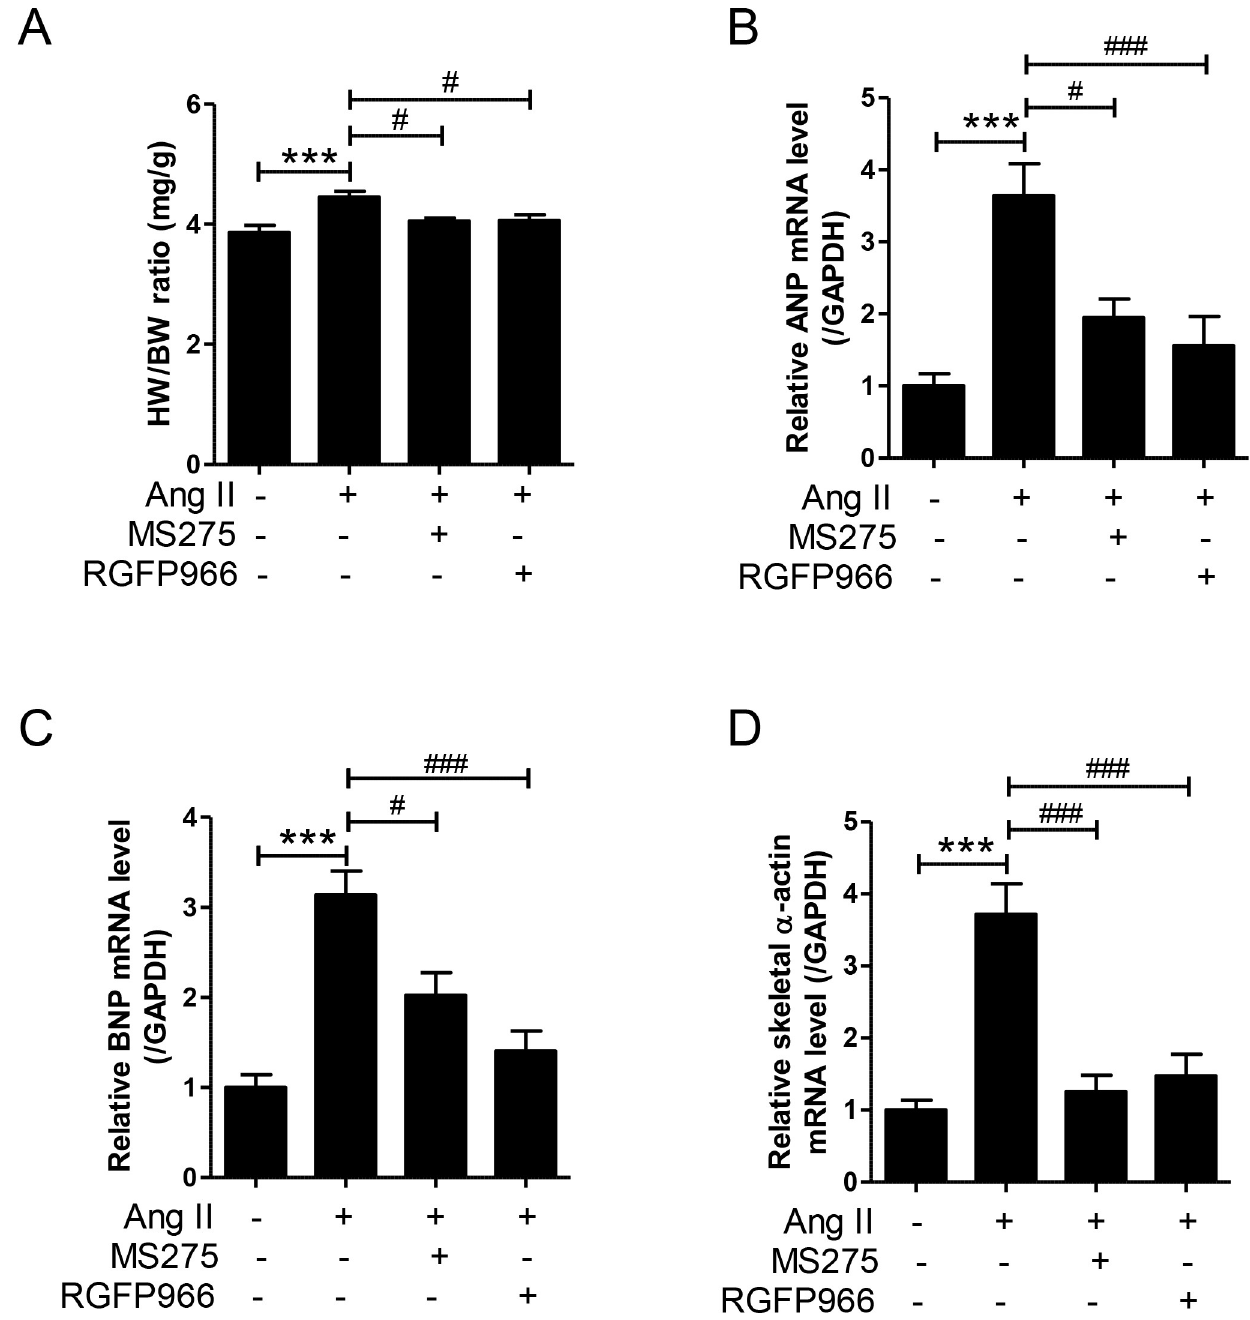
Fig 2. MS-275 and RGFP966 reduced cardiac hypertrophy in angiotensin II-induced hypertensive mice. (A) The HW/BW ratio was analyzed 2 weeks after Ang II infusion (n = 8 per group). ��� p < 0.001 versus sham group; # p < 0.05 versus angiotensin II (Ang II) group. (B–D) ANP, BNP, and skeletal α - actin mRNA was estimated by qRT-PCR. ��� p < 0.001 versus sham group; # p < 0.05 and ### p < 0.001 versus angiotensin II